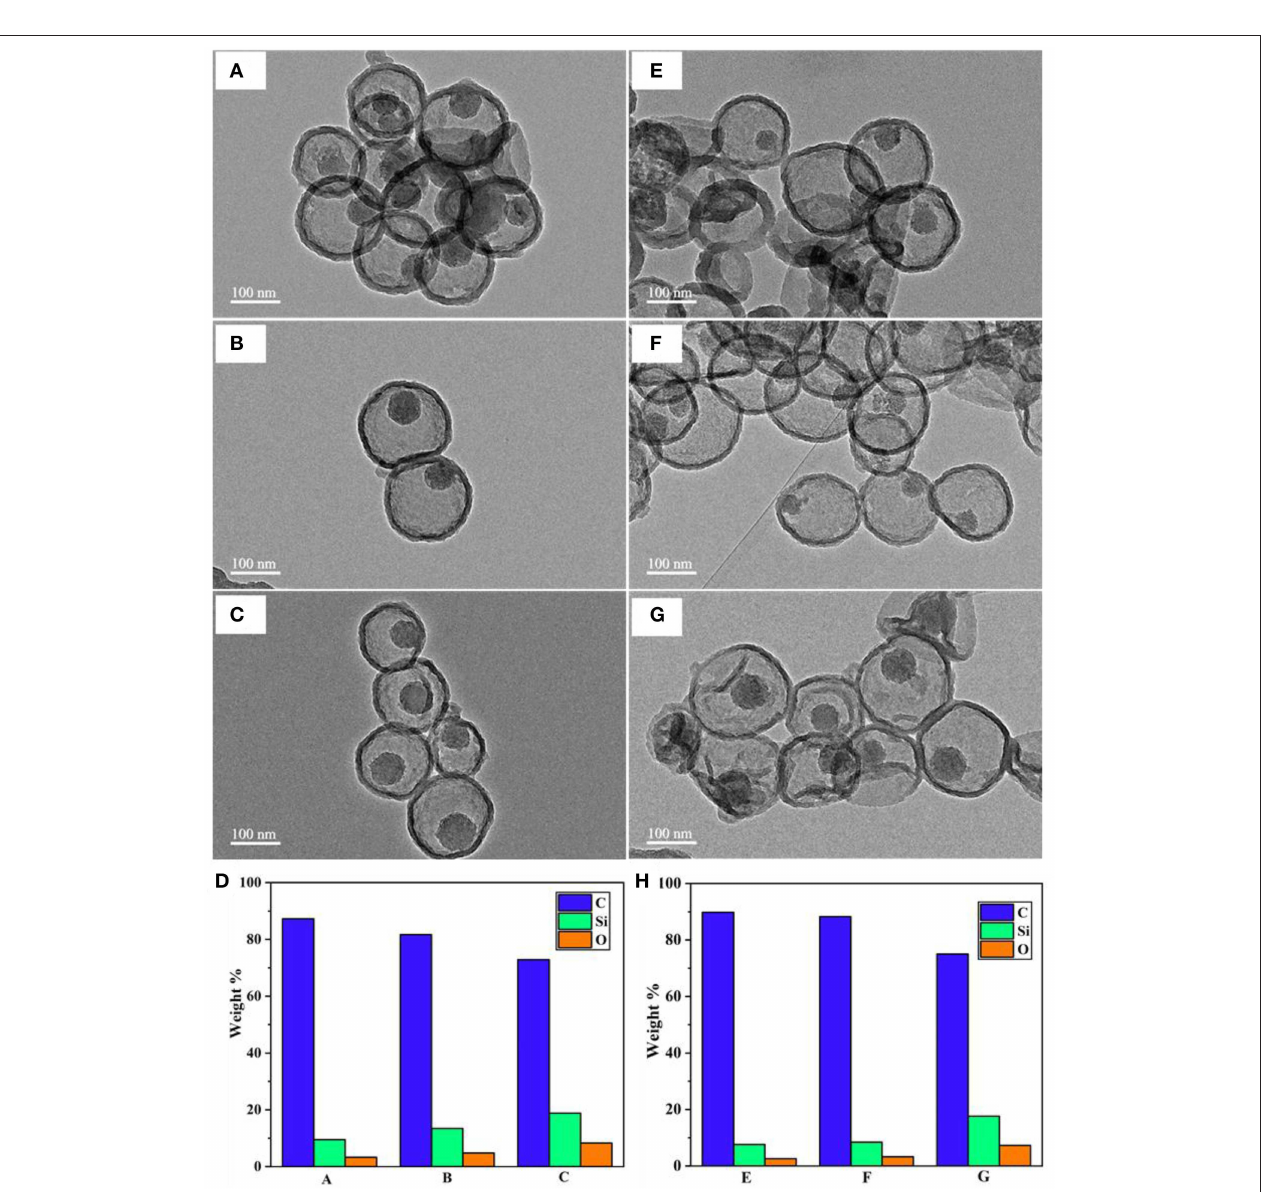
FIGURE 5 | TEM images of MSN@PDA with different MSN calcination time: 2, 4, and 6h after 24 h- ( A–C , respectively) and 48 h-water dispersion ( E–G , respectively), and their corresponding EDS analysis ( D,H , respectively).